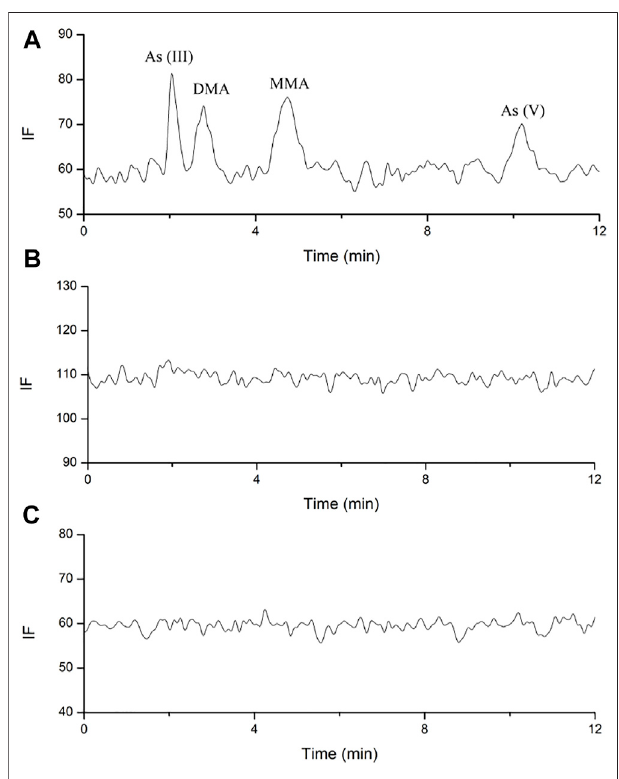
FIGURE2| Concentration-timepro fi les ofhumanurine arsenicafter oral administration of NHJDT. (A) . single dose ( n (cid:1) 9); (B) . multiple doses ( n (cid:1) 4).